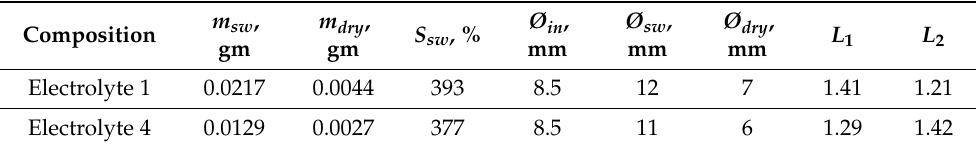
Table 4. Swelling, linear elongation, and linear shortening coefficients of electrosynthesized PMAA/AuNPs